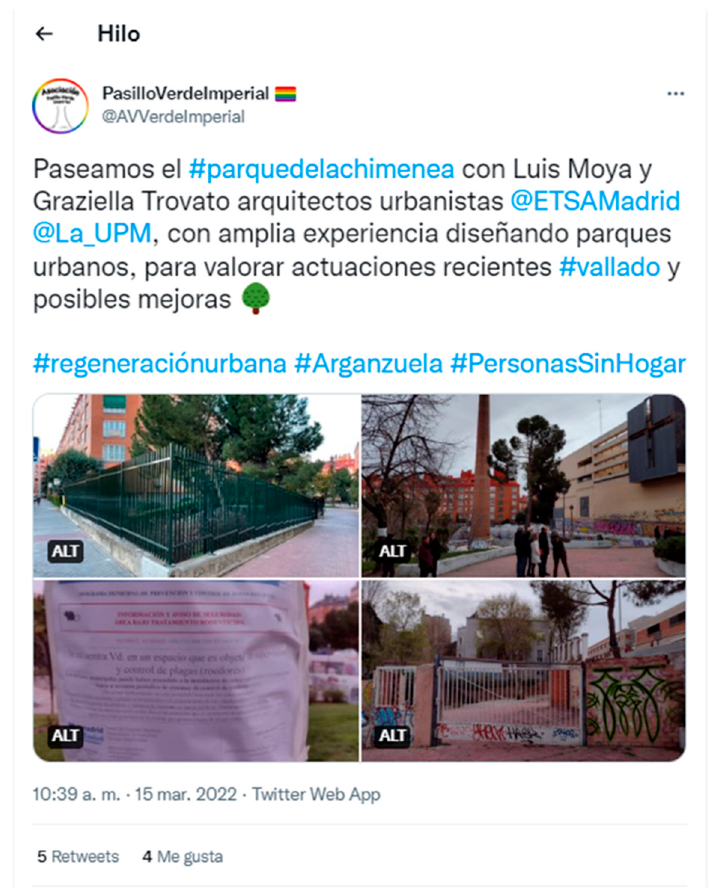
Figure 6. Fieldwork in the PVF. Action organized by the Pasillo Verde Imperial Association in the Parque del Gasómetro via Twitter. It reads: “We walked the #parquedelachimenea with the urban